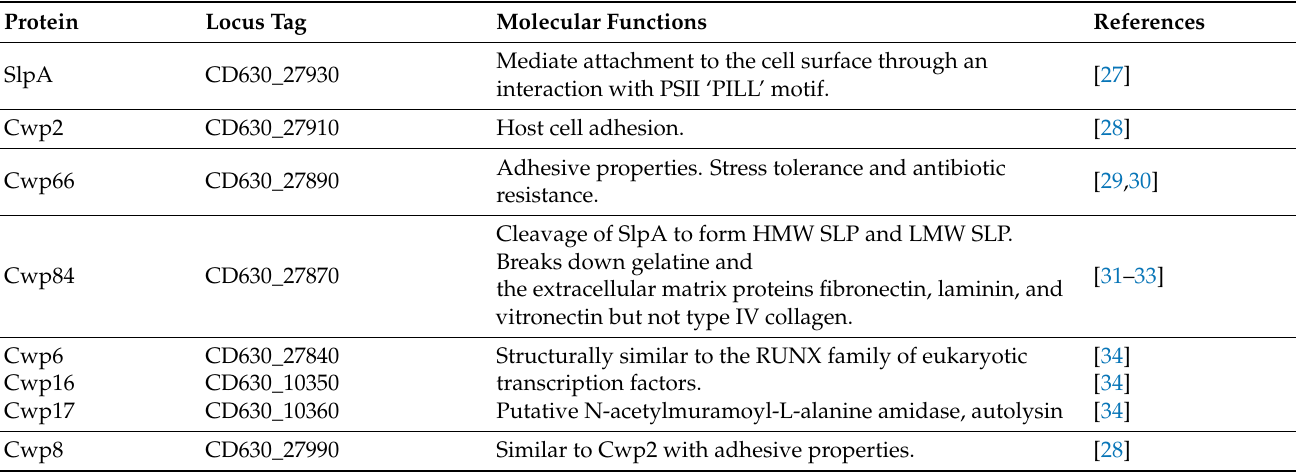
Table 1. Putative functions of the 29 cwp genes found in the Clostridium difficile 630 genome. Protein Locus Tag Molecular